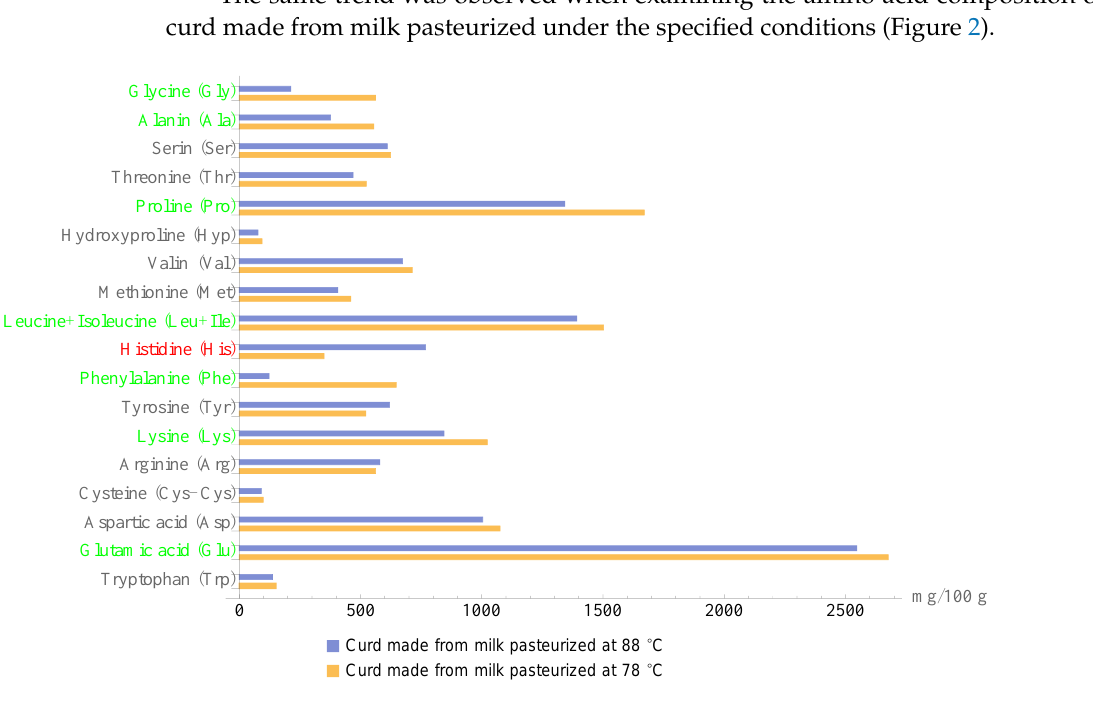
Table 4. Physical, chemical, and biological properties of the acid fat-free curd samples. a – c : Means in columns which do not share the same superscript letter were significantly different.